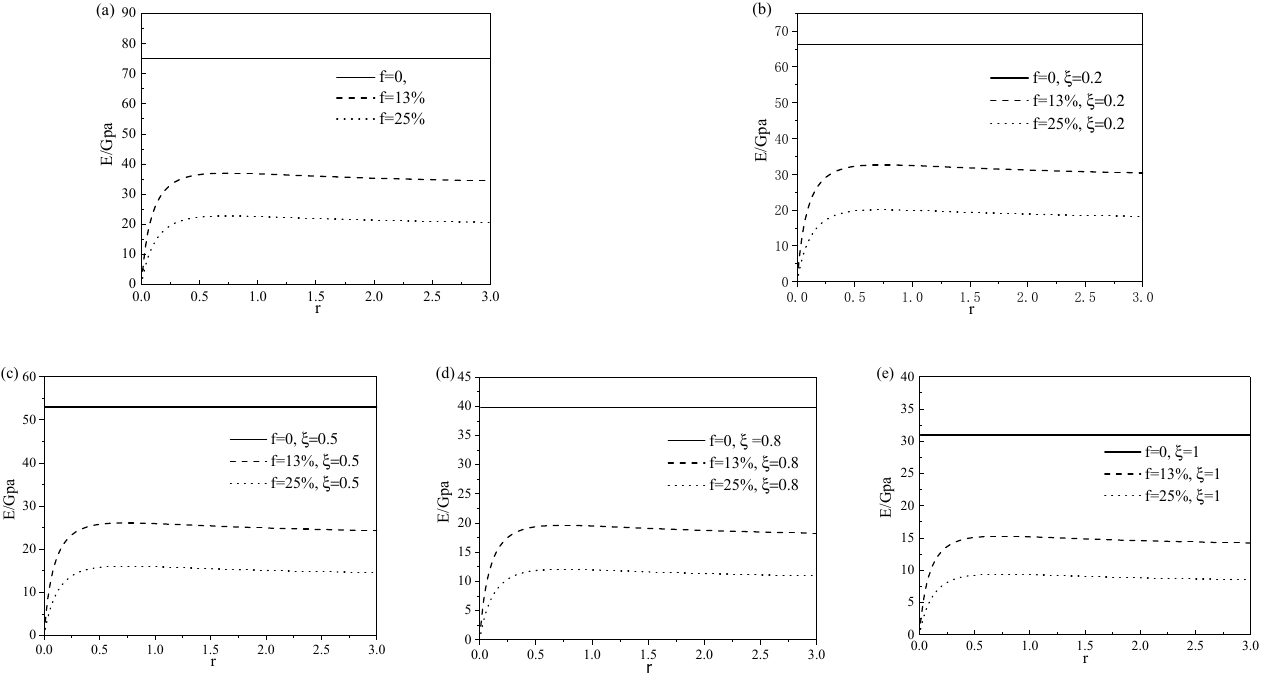
Figure 2. Relationship between Young’s modulus in different phase states and the aspect ratio of porous SMA at porosities of 0%, 13%, and 25%: ( a ) pure austenitic phase, ( b ) mixed martensite and austenite phase at ξ = 20%, ( c ) mixed martensite and austenite phase at ξ = 50%, ( d ) mixed martensite and austenite phase at ξ = 80%, and ( e ) pure martensite